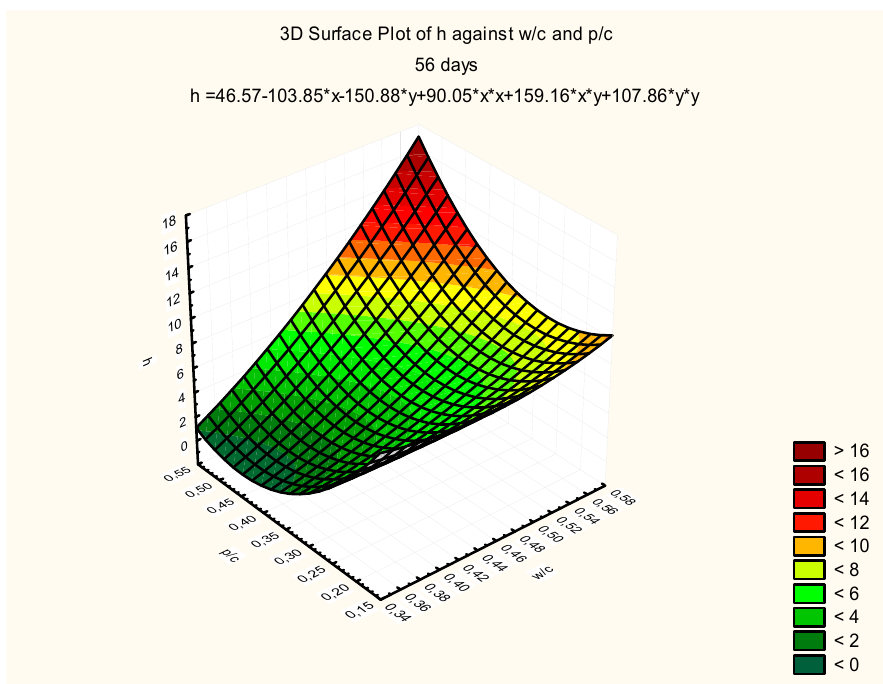
Figure 7. Depth of carbonation as a function of w/c and p/c, after exposure time t = 56 days, R 2 = 0.93.